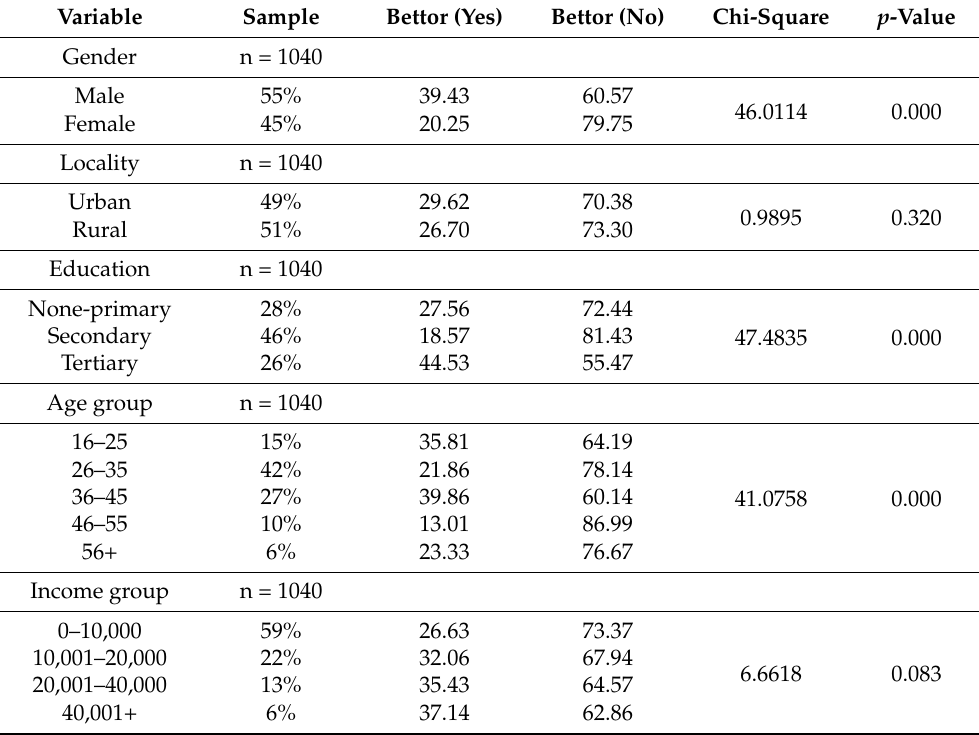
Table 1. Bivariate relationship between betting and socio-demographic